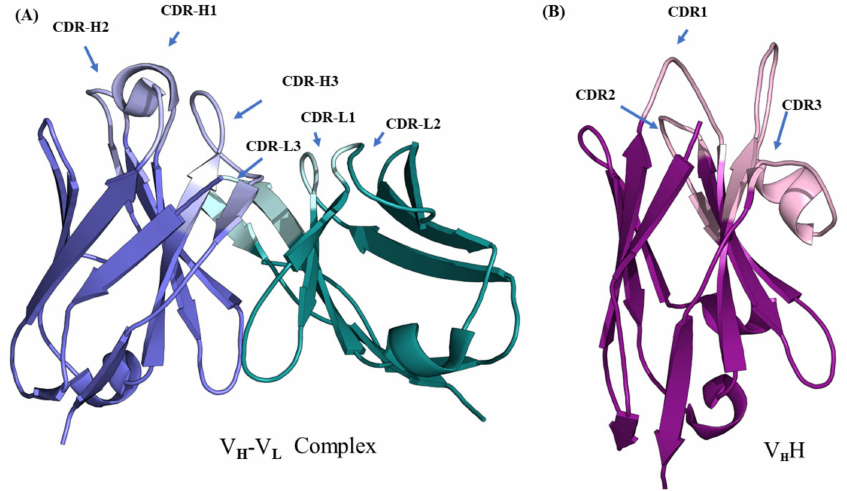
Figure 1. Structural representation of variable regions of immunoglobulins. ( A ) VH–VL complex (taken from PDB ID 4P49 [1]) and ( B ) V H H (taken from PDB ID 1JTO [5]). The lighter colored regions represent complementarity determining regions (named CDR-H and CDR-L for the VH-VL complex and CDR for V H H) and darker colored regions the framework regions in each